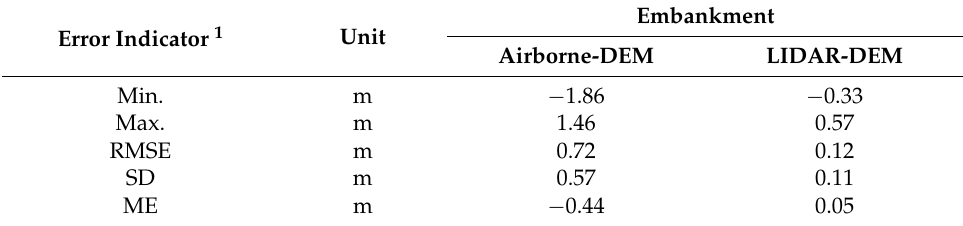
Table 2. Result of Airborne-DEM and LIDAR-DEM embankment